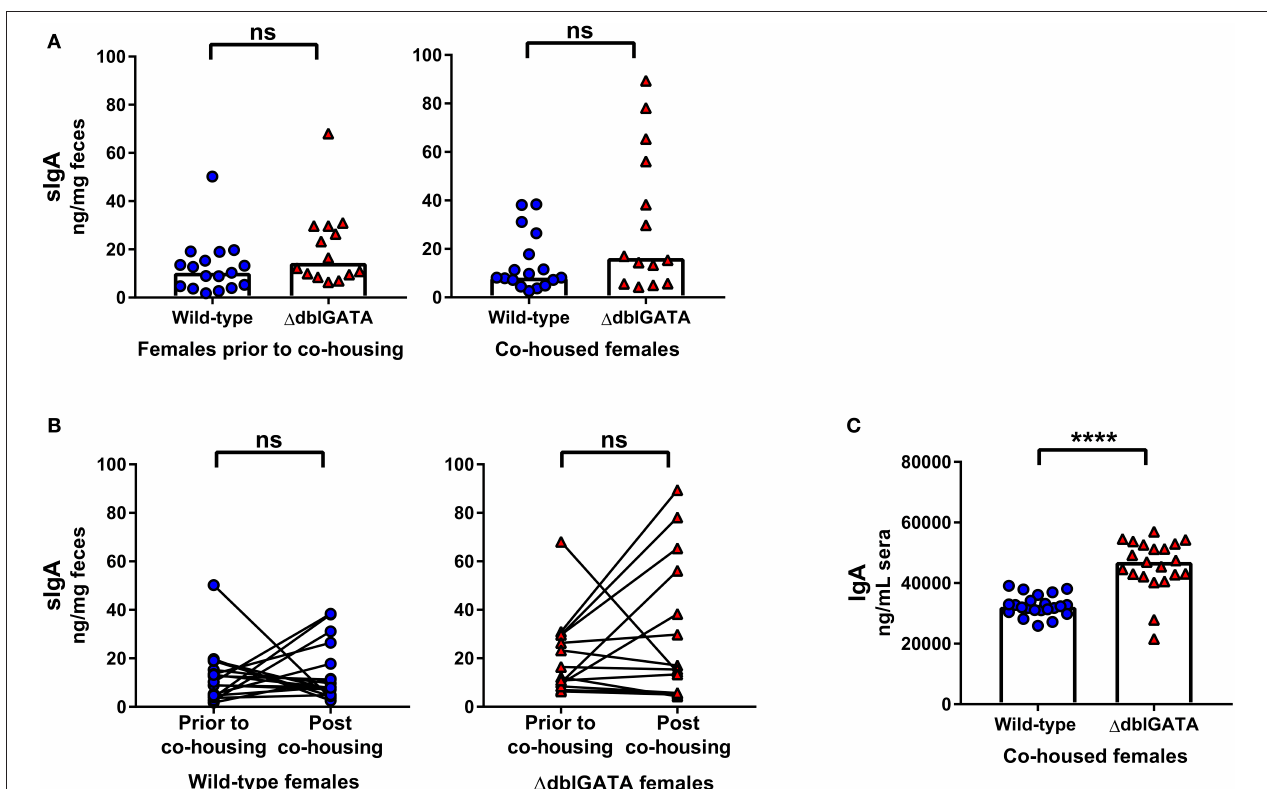
FIGURE 1 | No impairment in steady-state IgA levels in female 1 dblGATA mice prior to or following co-housing with wild-type mice. Feces was collected from 6 – 11 week old female wild-type and 1 dblGATA BALB/cJ mice prior to and following 1 week of cohousing (“co-housed”). Serum was collected following co-housing. Fecal sIgA and serum IgA levels were quantified by ELISA. (A) Fecal sIgA data shown are pooled from four independent experiments, with a combined n = 14–17 in each group. Column heights are at the median value for each group and data were analyzed by a Mann-Whitney test. (B) The same data shown in (A) was assessed for the effect of co-housing on sIgA in individual mice using a Wilcoxon test on paired (pre- and post-cohousing) samples. (C) Serum IgA data shown are pooled from four independent experiments, with a combined n = 21–22 in each group. Column heights are at the median value for each group and data were analyzed by a Mann-Whitney test. Each data point is representative of an individual mouse. ns, no statistical differences; **** = p ≤